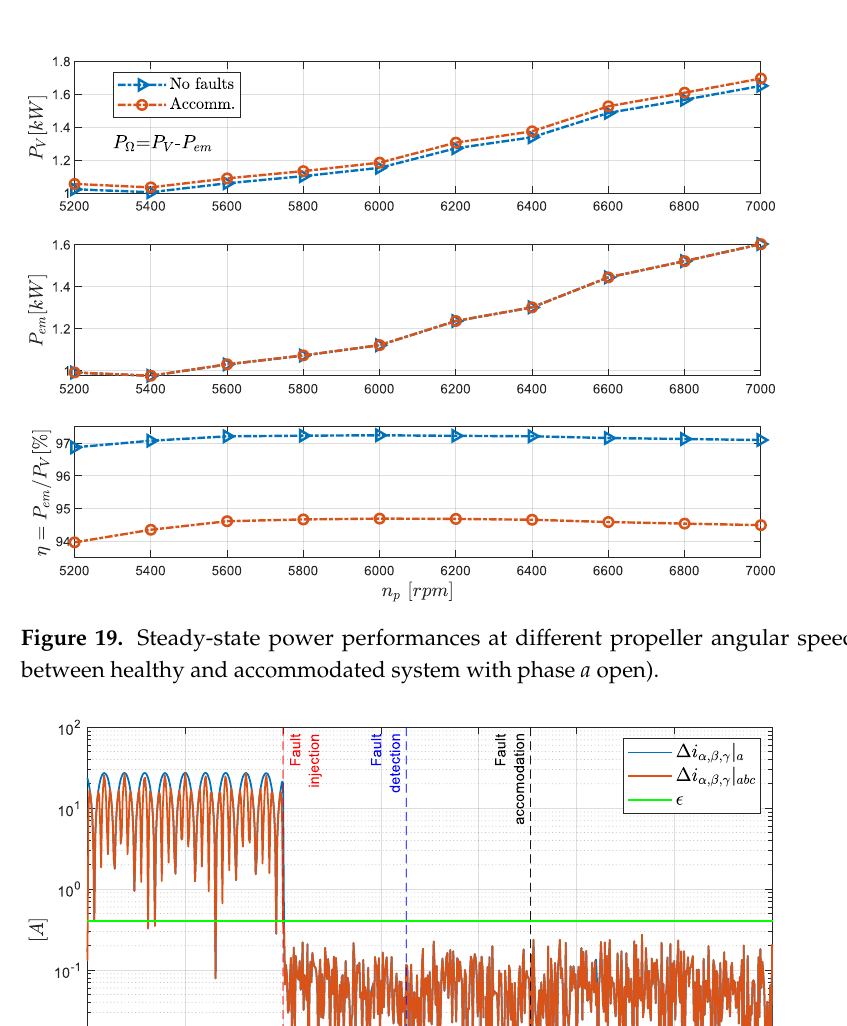
Figure 19. Steady-state power performances at different propeller angular speeds (comparison be- tween healthy and accommodated system with phase a open).